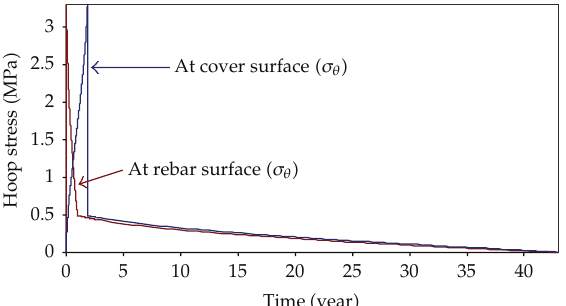
Figure 7: Hoop stress (cid:5) σ θ (cid:6) at rebar surface and at cover surface with time t